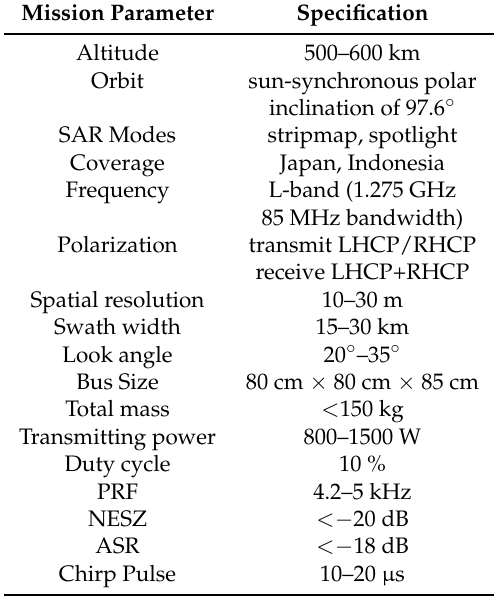
Table 3. Mission and antenna specifications.